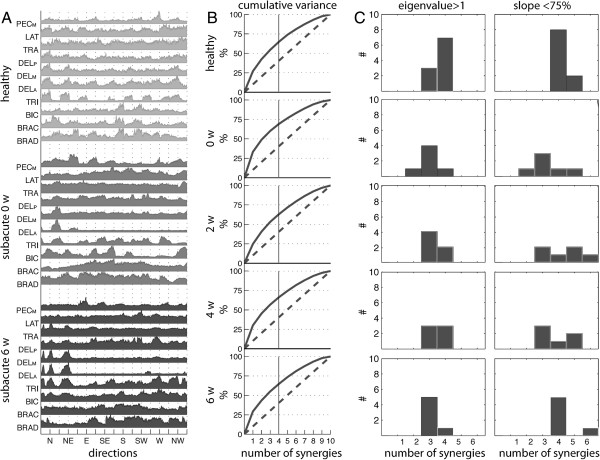
EMG signals, cumulative variance and number of retained muscle synergies according to the adopted criteria. (A) EMG signals related to ten upper limb muscles were collected during robot-mediated treatment. Representative EMGs for a healthy and subacute patient (at 0 and 6 weeks) are shown. Only for graphical purpose data were normalized in amplitude for their maximum value. Labels on the vertical axis are: BRAD, brachioradialis; BRAC, brachialis; BIC, biceps brachii; TRI, triceps brachii; DELA, anterior part of deltoid; DELM, medial part of deltoid; DELP, posterior part of deltoid; LAT, latissimus dorsi; TRAP, trapezius superior; PECM, pectoralis major. Labels on the horizontal axis are: N, North; NE, Northeast; E, East; SE, Southeast; S, South; SW, Southwest; W, West; NW, Northwest. (B) Average values of the cumulative variance related to muscle synergies extracted form the original datasets (solid line) and those extracted from shuffled dataset (dot line) as a functions of the number of extracted synergies for healthy subjects and subacute patients. (C) Histograms of the number of muscle synergies to be retained in accordance with the eigenvalue > 1 criterion (left column) and the slope of the cumulative variance-based criterion (right column).